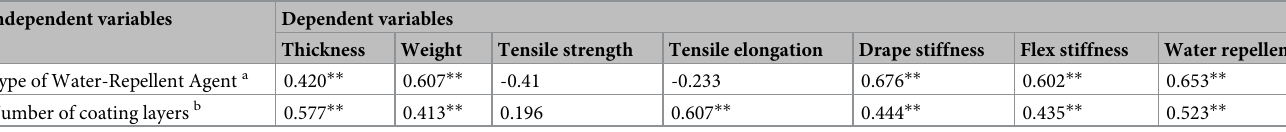
Table 3. Pearson’s correlation coefficients of the studied